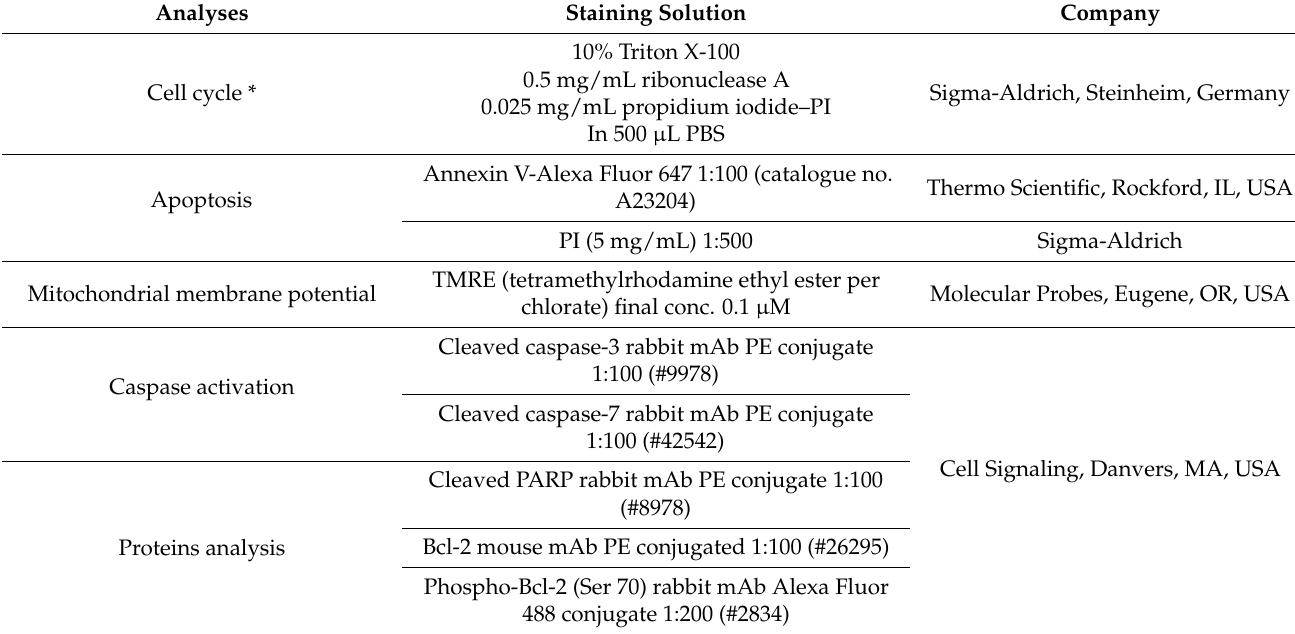
Table 7. List of flow cytometry analyses and